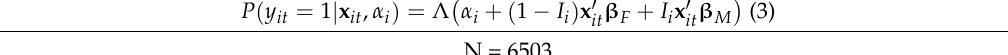
Table 5. Unrestricted Model, Coefficients, Standard Errors and Odds Ratios